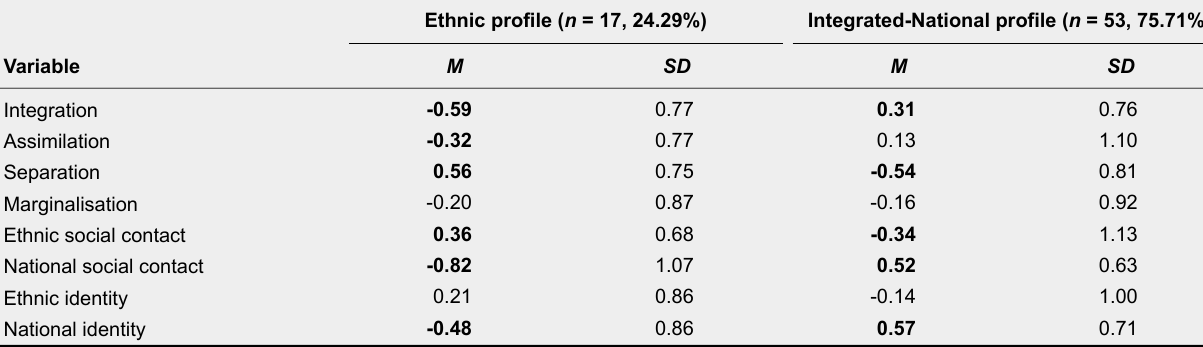
Means and Standard Deviations of Tunisian Acculturation Variables (Z-Scores) by Configuration in Second-Generation Immigrant Adolescents (n =